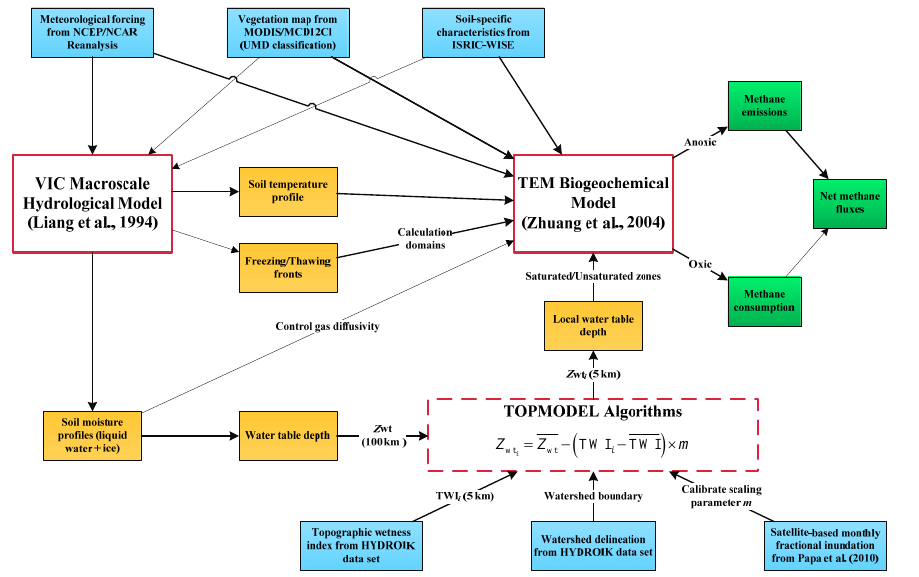
Fig. 1. Conceptual framework of coupled models to estimate net methane emissions. Shown are external spatial inputs (blue) for driving or calibrating models, internal information exchange (yellow) between models, and final model outputs (green). Arrows indicate the direction of information exchange among all components. See text and auxiliary materials for more